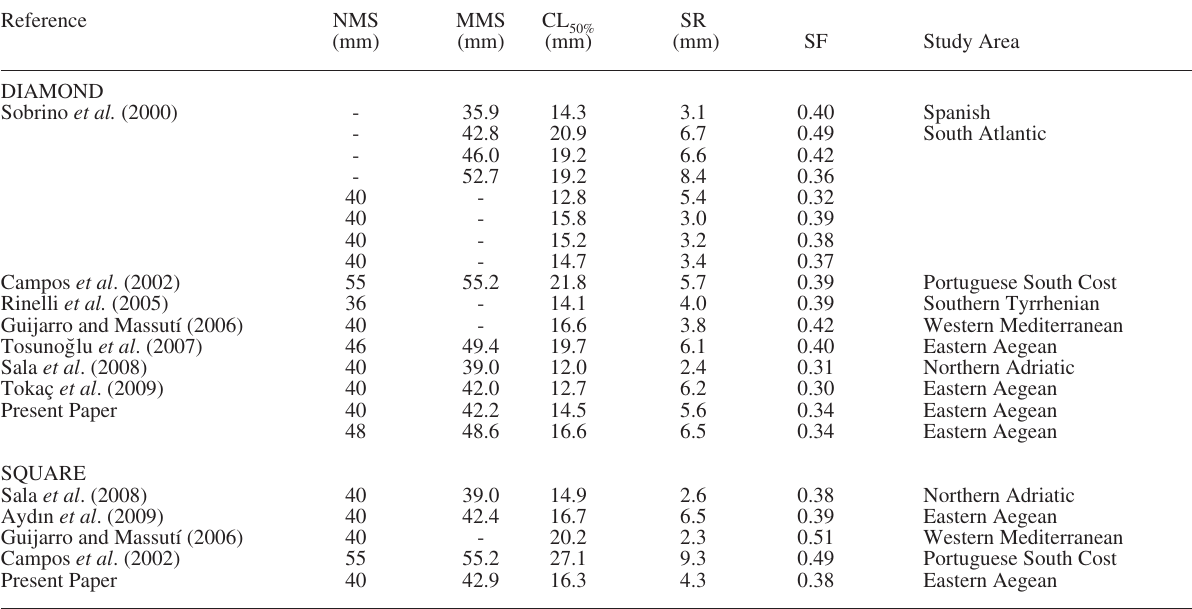
Table 3. – Result of the previous studies in the Mediterranean and adjacent waters. nMs, nominal mesh size; MMs, measured mesh size;